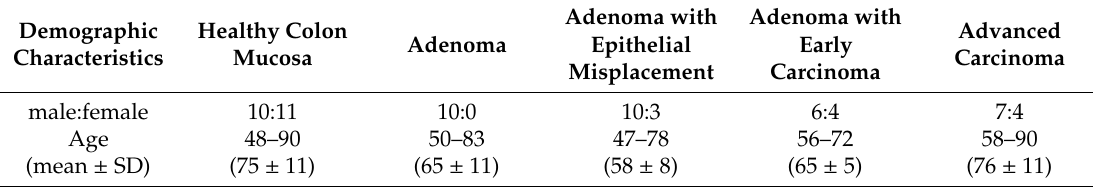
Table 1. Gender and age of the patients included in the study.